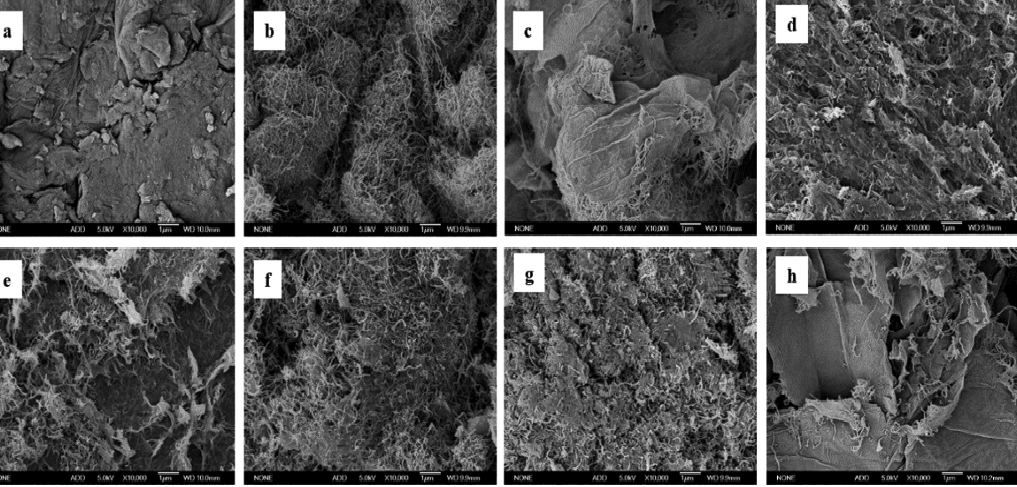
Figure 4. SEM images of ( a ) GO, ( b ) MWCNTs, ( c ) 0.5-rGO-MWCNTs, ( d ) 1.0-rGO-MWCNTs, ( e ) 1.0-β-CD/rGO-MWCNTs-1, ( f ) 1.0-β-CD/rGO-MWCNTs-6, ( g ) 1.0-β-CD/rGO-MWCNTs-12, and ( h ) 1.5-rGO-MWCNTs adapted with permission from [99].